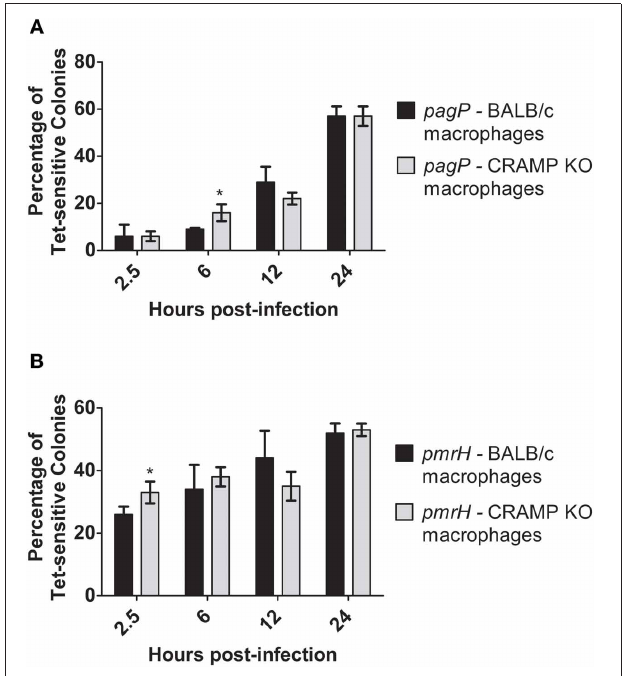
FIGURE 5 | TCRS-mediated pagP and pmrH activation in bafilomycin-treated WT and CRAMP KO macrophages. BALB/c and CRAMP-deficient mouse bone marrow-derived macrophages were pre-treated with bafilomycin in DMSO and infected with the S. Typhimurium (A) pagP or (B) pmrH RIVET strain. Gentamicin-treated macrophages were lysed at 2.5, 6, 12 and 24h p.i., Lysates containing intracellular bacteria were plated on LB. Resulting colonies were patched onto LB and LB Tet to detect loss of Tet-resistance due to promoter activation. Graphed values represent the mean ± standard deviation of one representative experiment performed at least twice in